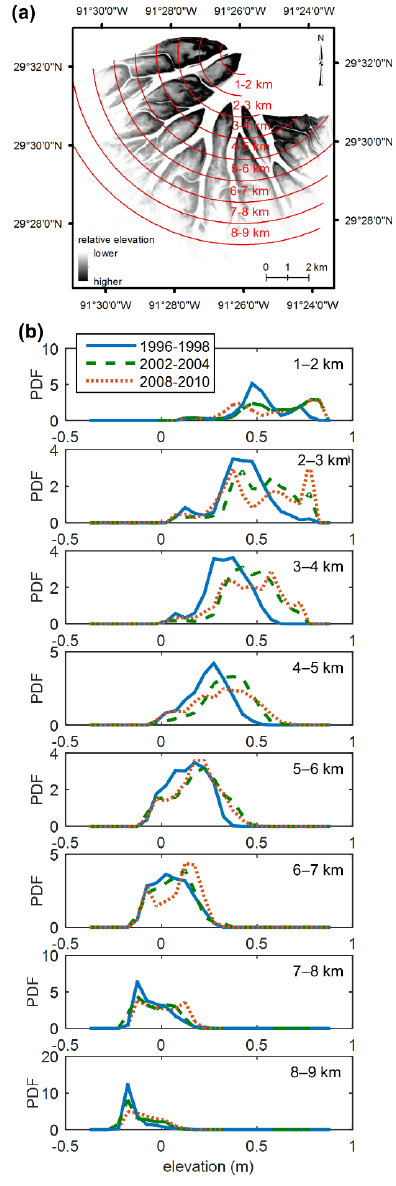
Figure 7. ( a ) Map of Wax Lake Delta islands, schematic land elevation, and distances from delta apex. ( b ) Change over time in probability density functions (PDFs) of island elevations at different distances. (Elevations in meters above North American vertical datum of